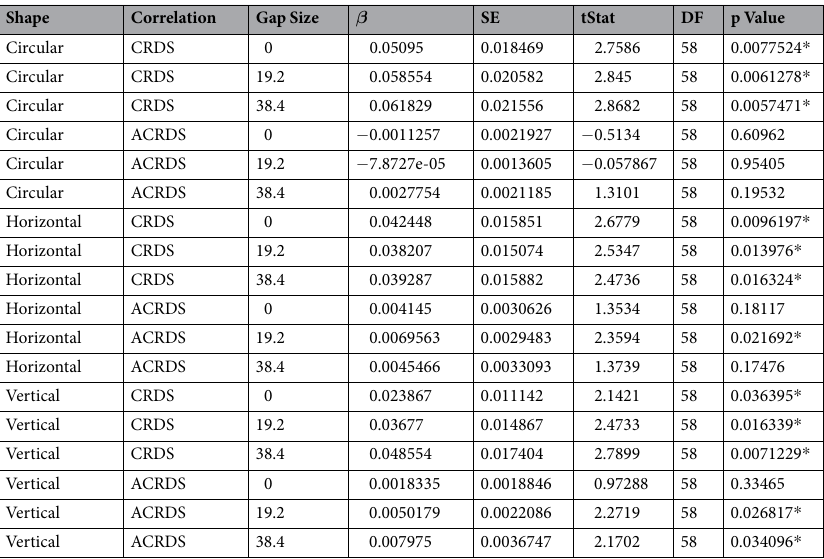
Table 1. Estimates of effects from the generalised linear mixed effects regression for the proportion of near versus far responses in CRDS and ACRDS stimuli. * Indicates significant p value.